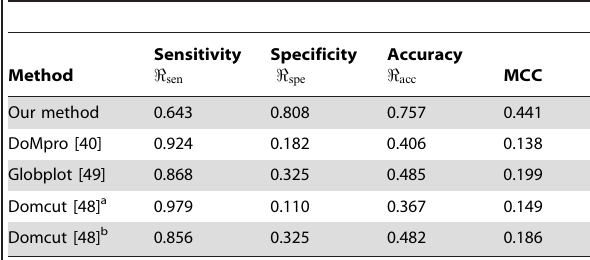
Table 3. Comparison of the current method with the existing methods on the same testing dataset S T (cf.